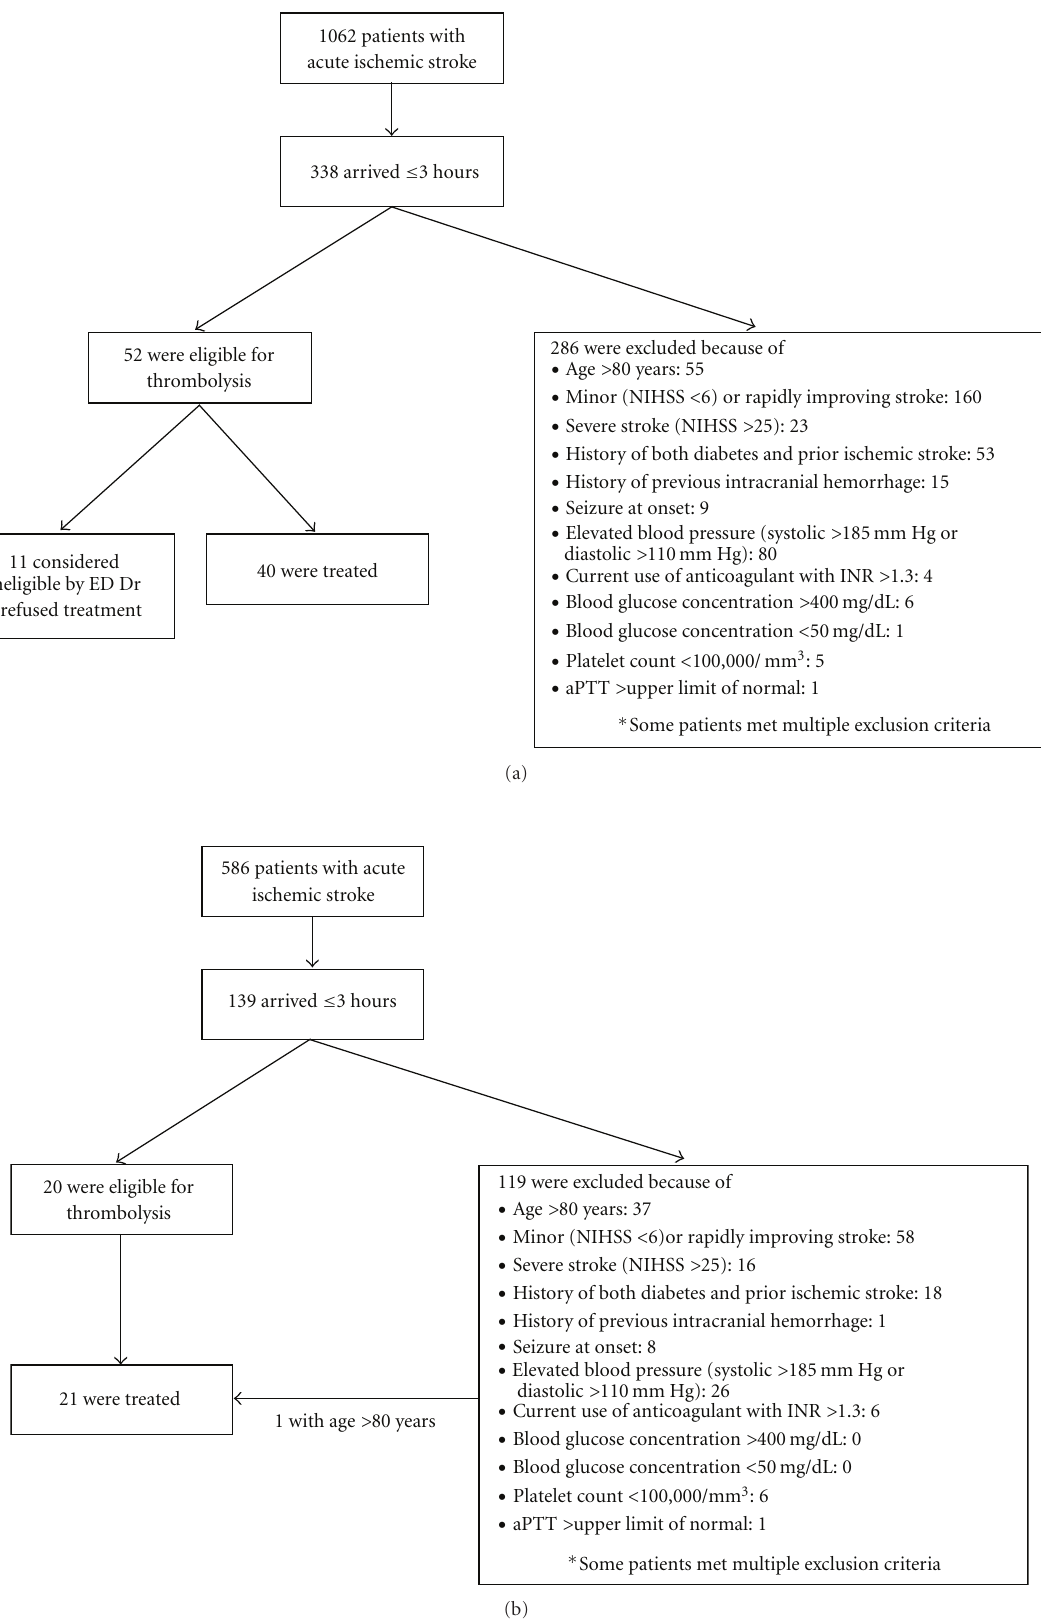
Figure 2: Clinical results before (a) and after (b) the implementation of the new thrombolysis